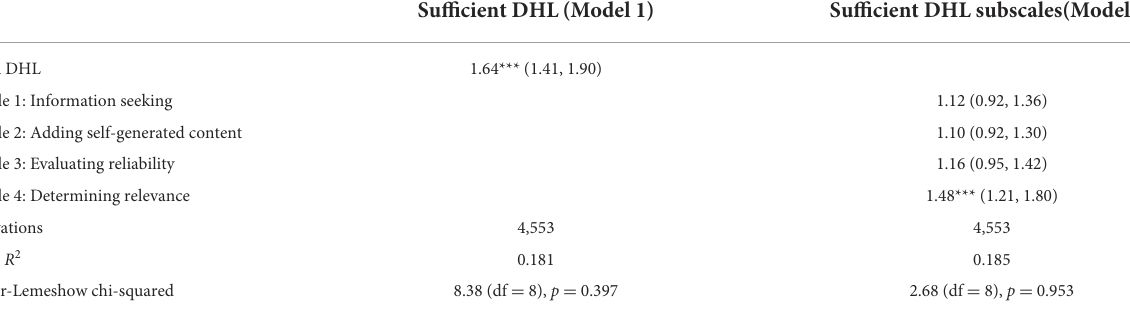
TABLE 3 Adjusted ORs (95% CI) for sufficient total DHL score and sufficient DHL subscales scores in relation to “intention for vaccination” #